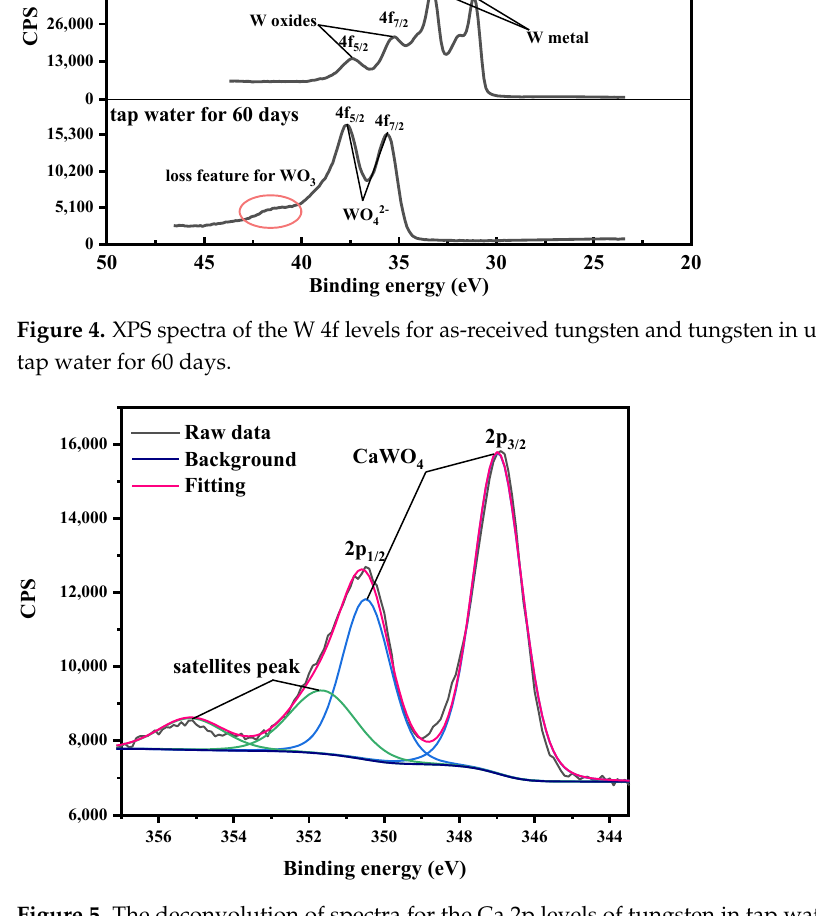
Figure 5. The deconvolution of spectra for the Ca 2p levels of tungsten in tap water for 60